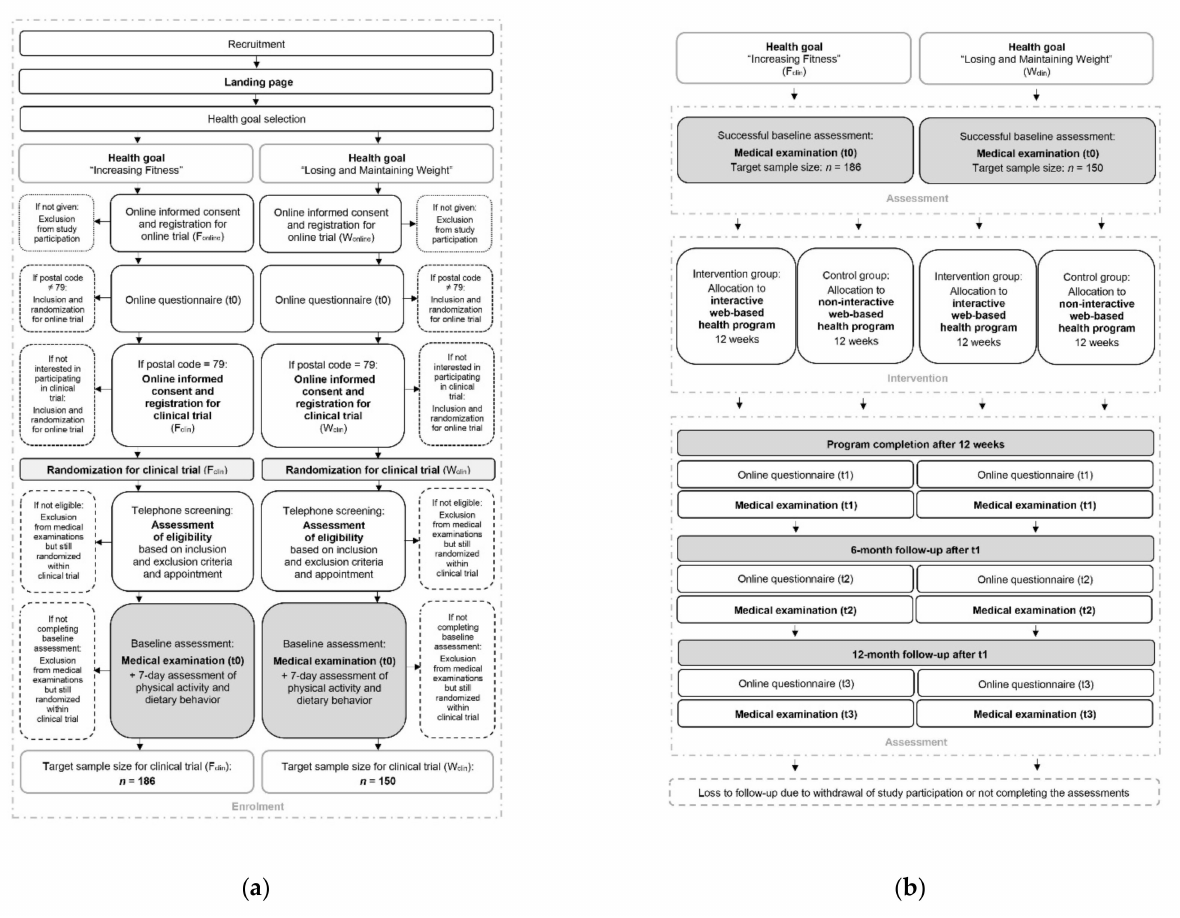
Figure 3. Participant timeline of the clinical fitness trial (F clin ) and the clinical weight loss trial (W clin ): ( a ) Enrolment process; ( b ) intervention and assessment